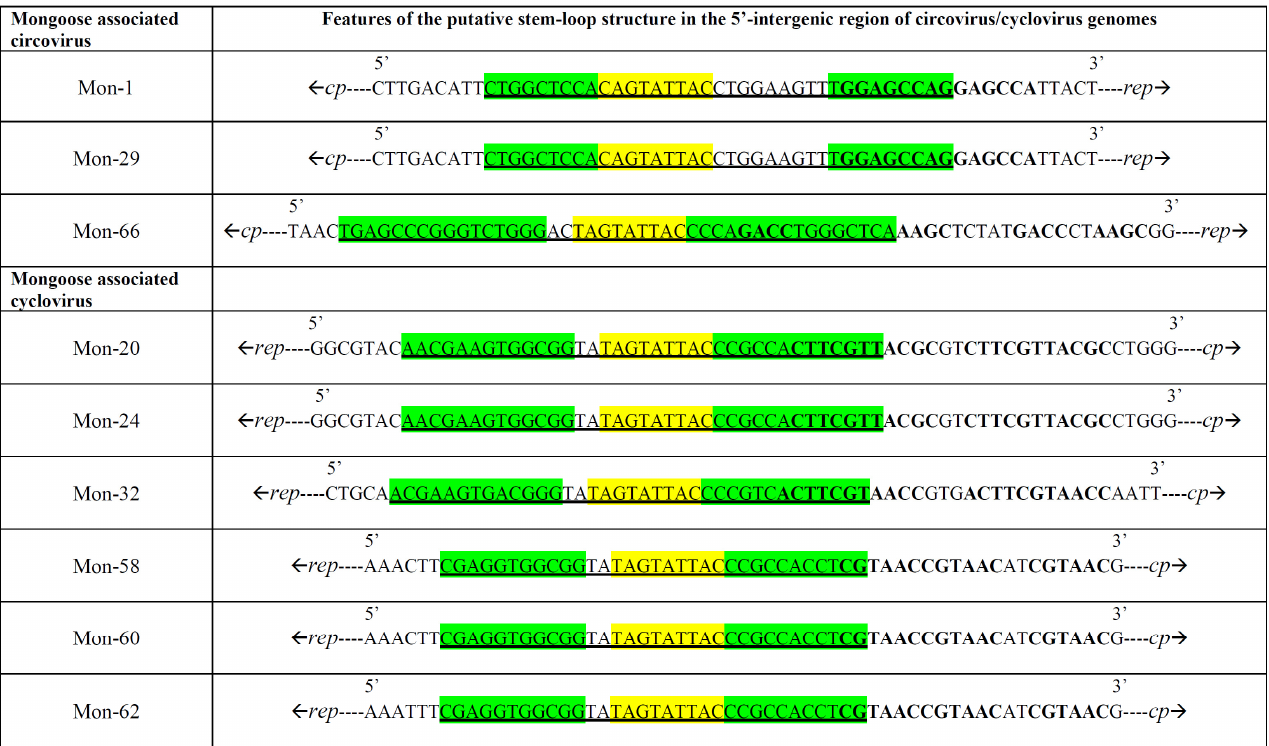
Figure 2. Genome organization of the mongoose associated circoviruses ( A ) and cycloviruses ( B ). The putative (Rep) and capsid (Cp) proteins are shown with blue and red arrows, respectively. The putative